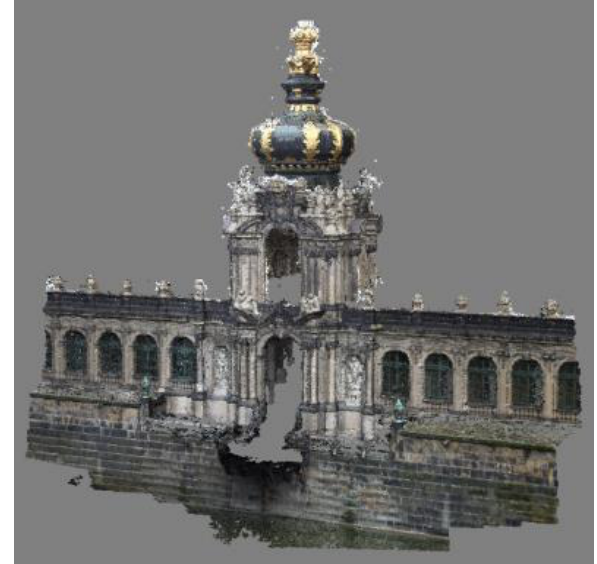
Figure 11. Point cloud based on recent images